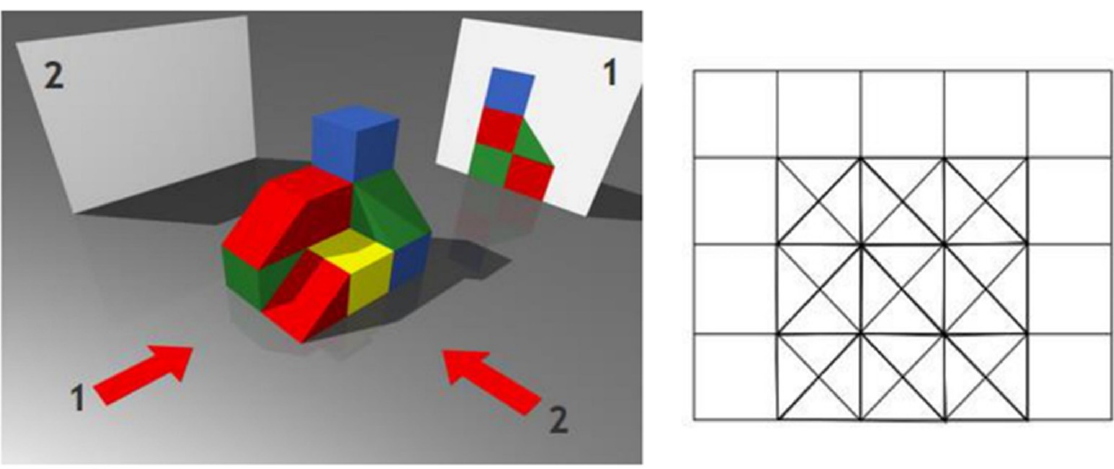
Figure 4. Assignment of Task